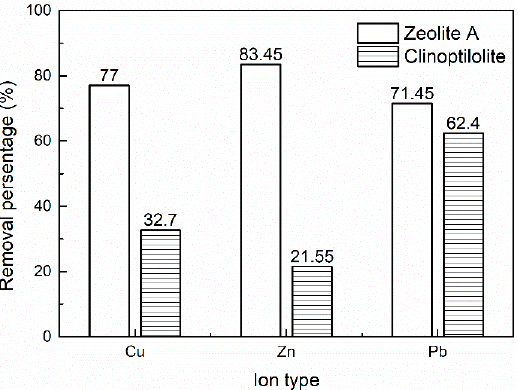
Figure 5. The removal percentages of clinoptilolite and zeolite A applied in different ions under 5 BV h − 1 at the end of the experiment.